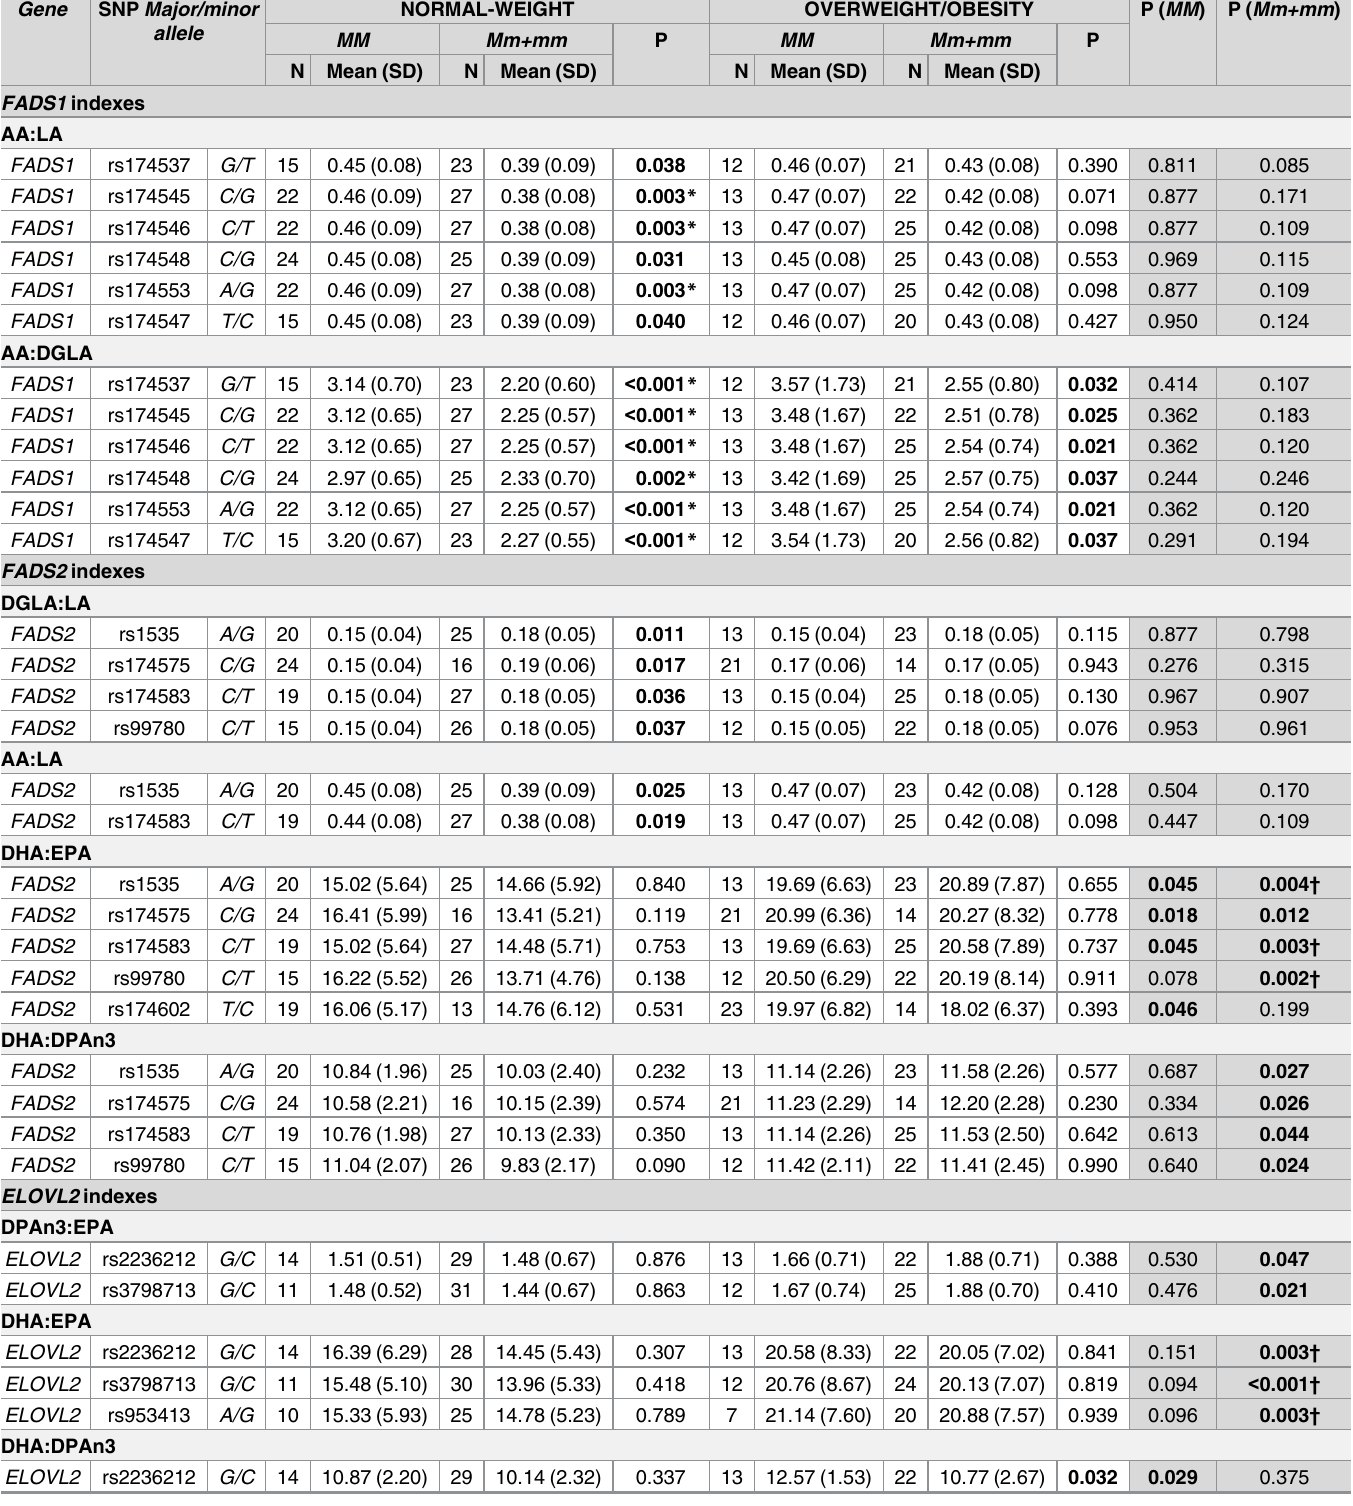
Table 4. FADS1 , FADS2 and ELOVL2 enzymatic indexes according to maternal SNPs and LC-PUFA levels in plasma. Gene SNP Major/minor